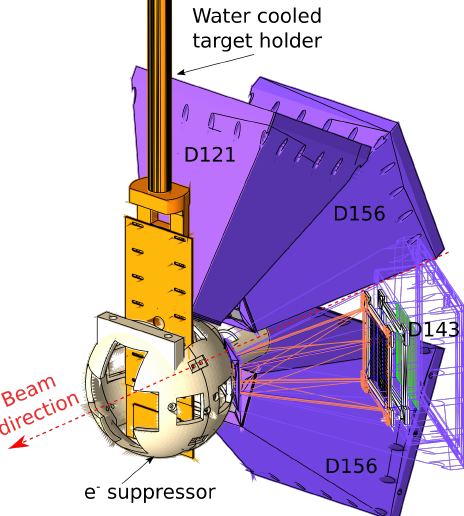
Figure 1. Sketch of the GASTLY detectors arrangement. The four GASTLY detectors are shown along with the target holder and the sphere surrounding it for electron suppression purposes. Detector D143 is shown in wire-frame to reveal its internal components. Figure taken from [20] (published under a Creative Commons Attribution 4.0 International